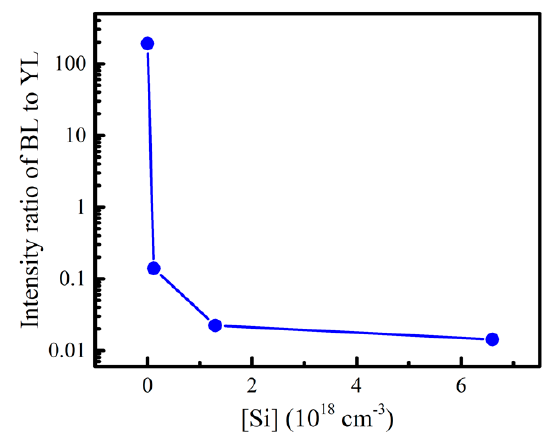
Figure 6. Dependences of the intensity ratio of BL to YL of n-GaN samples A0–A3 on the Si concentration. The blue line is used to guide the eye.